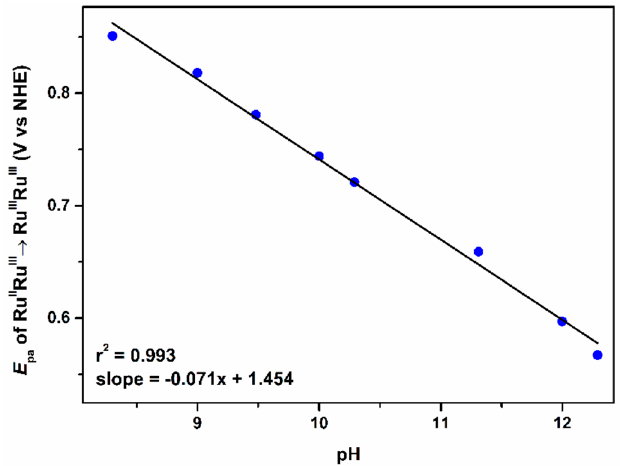
Figure 7. The cyclic voltammograms of the redox wave are recorded in various bicarbonate concen- trations. However, no significant change in the peak potential/current was found (Figure S9). This is because bicarbonate replaces the hydroxide ion after the redox process and is not involved in the electron transfer step.